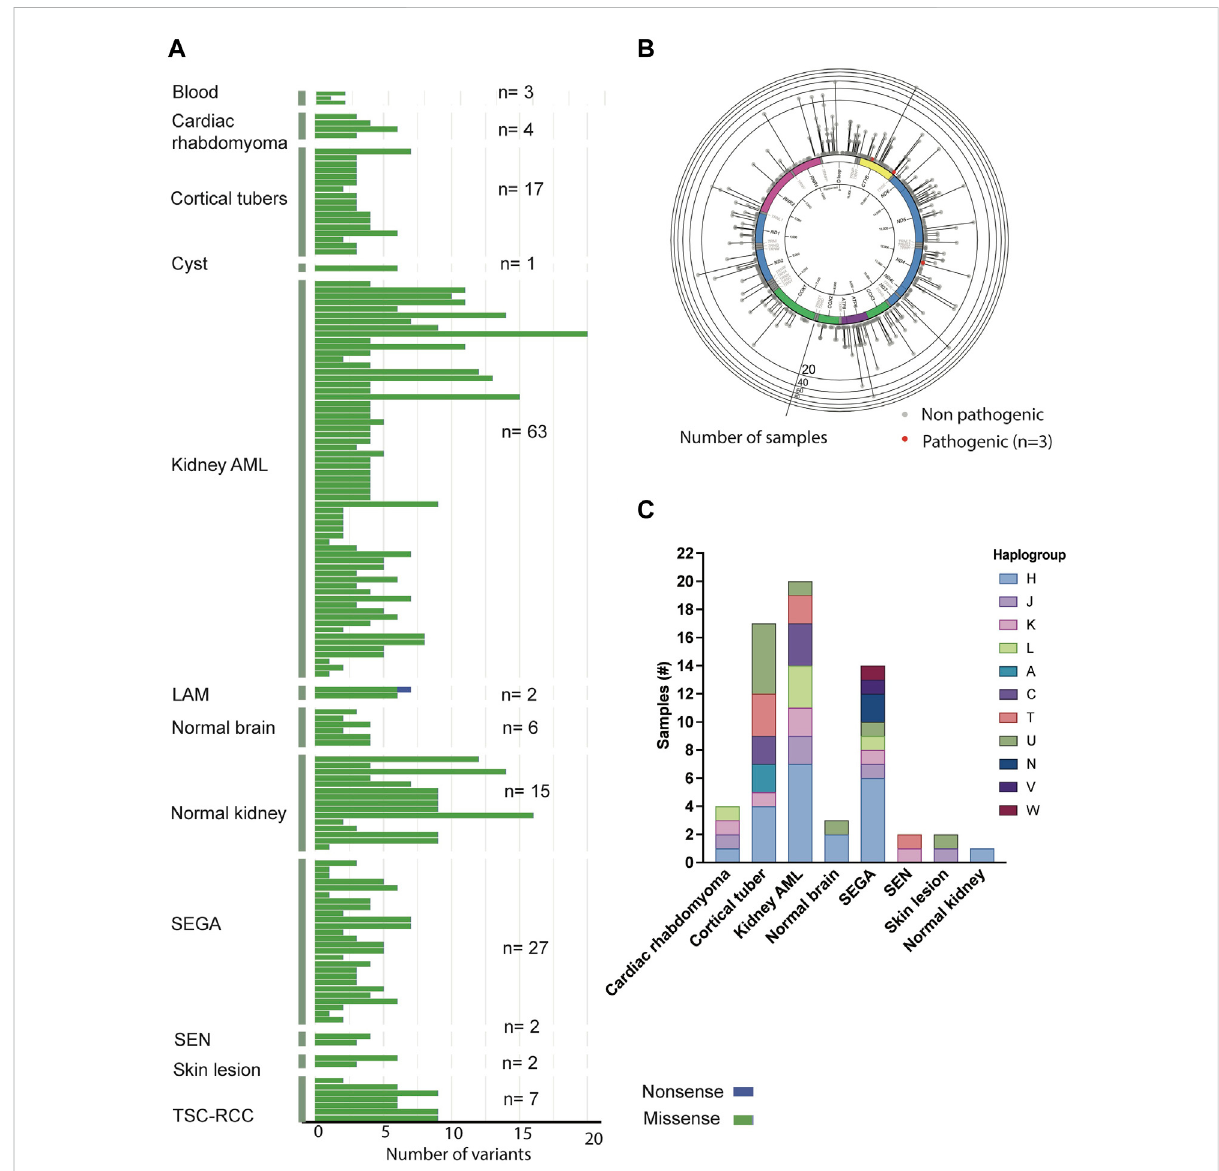
FIGURE 4 Analysis of mtDNA in TSC-associated tumors. (A) Distribution and frequency of missense, non-sense, and frameshift variants identi fi ed in TSC- associated tumors and corresponding normal tissues. (B) Gene location and prevalence of mtDNA variants identi fi edin TSC-associated tumors.Red spots indicate three potentially pathological mtDNA variants identi fi ed by in silico prediction software and annotated in Table 2. (C) Distribution of haplogroups across 63 TSC-associated tumors (n = 63).